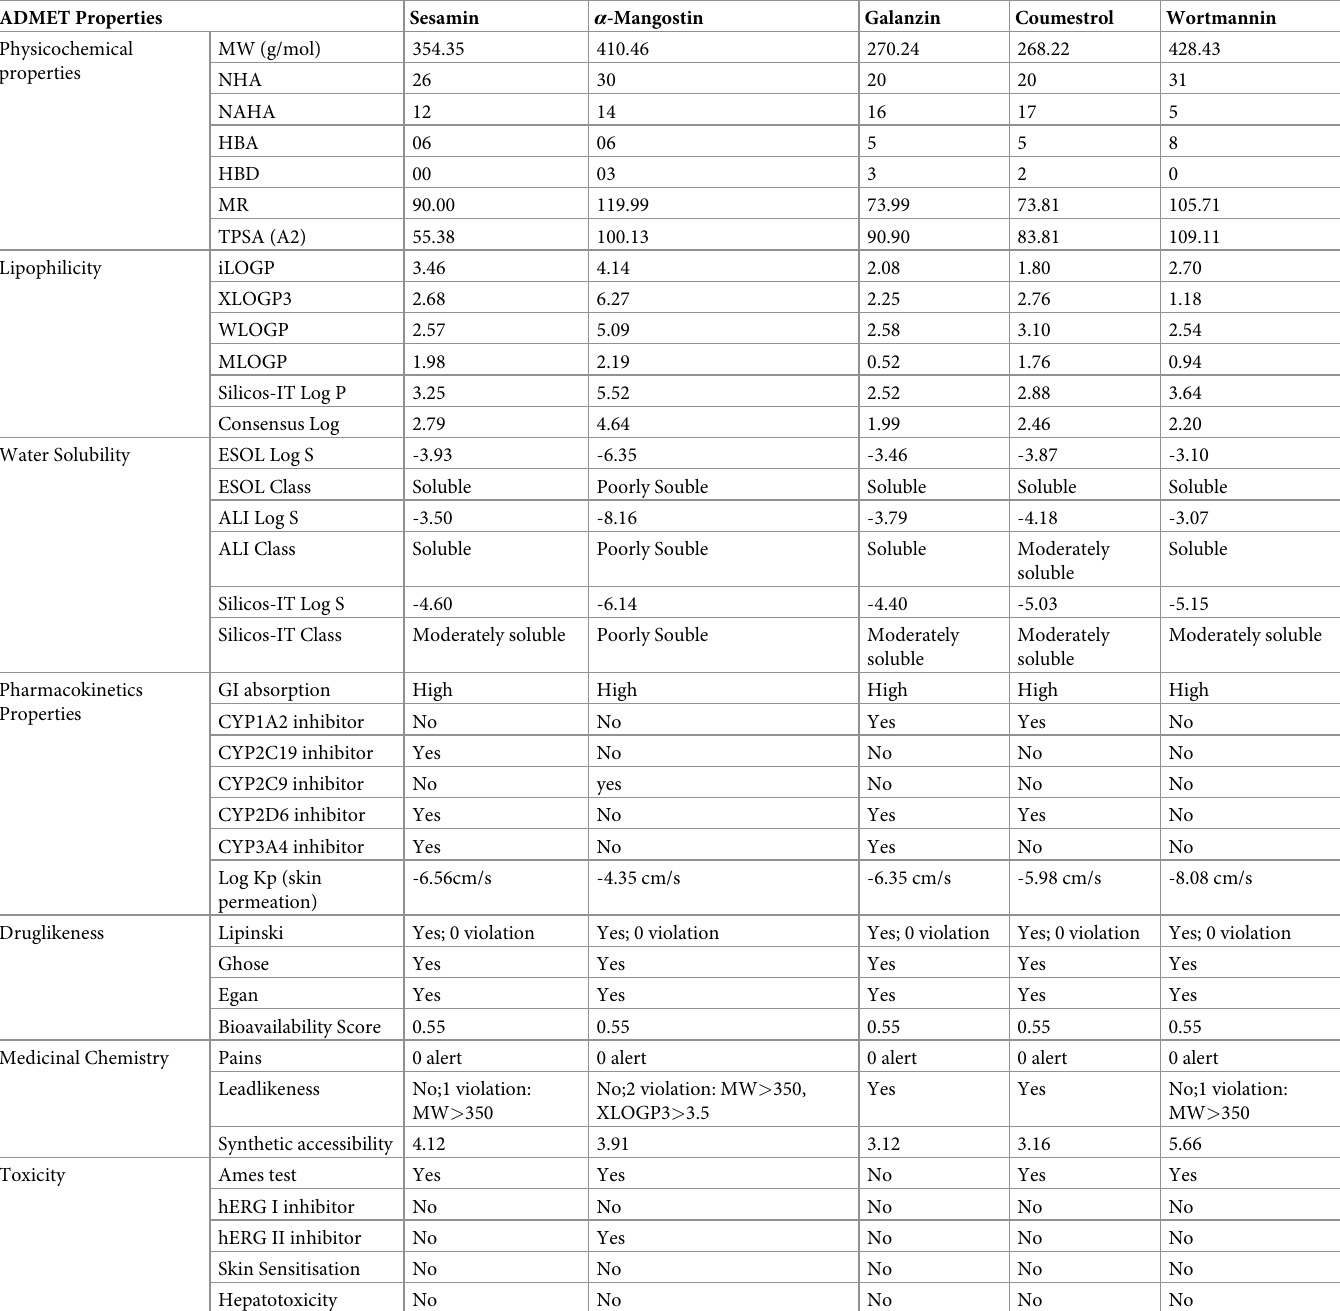
Table 7. Chemo-informatics analysis of selected